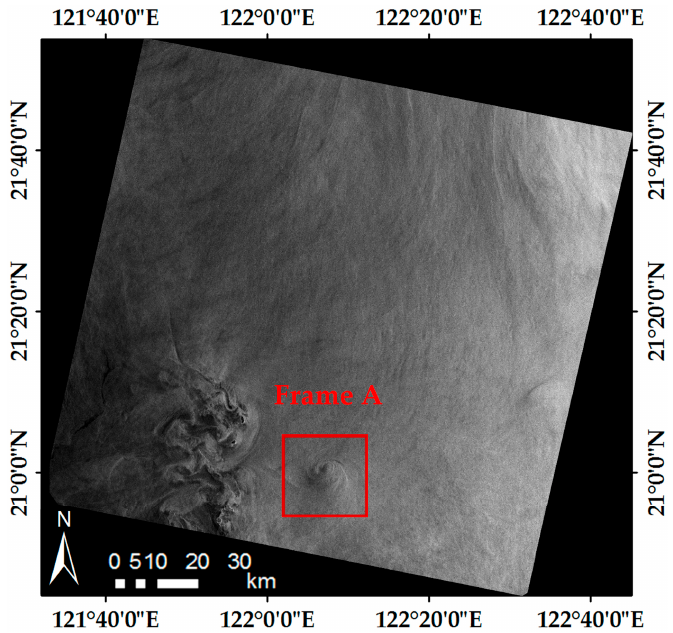
Figure 5. ENVISAT ‐ 1 ASAR image of the Luson Strait acquired on 27 April 2005 at 01:53:42 UTC. Frame A (20 km × 20 km) highlights a shear ‐ wave ‐ generated eddy. Table 3. The related parameters of ENVISAT ‐ 1 ASAR.